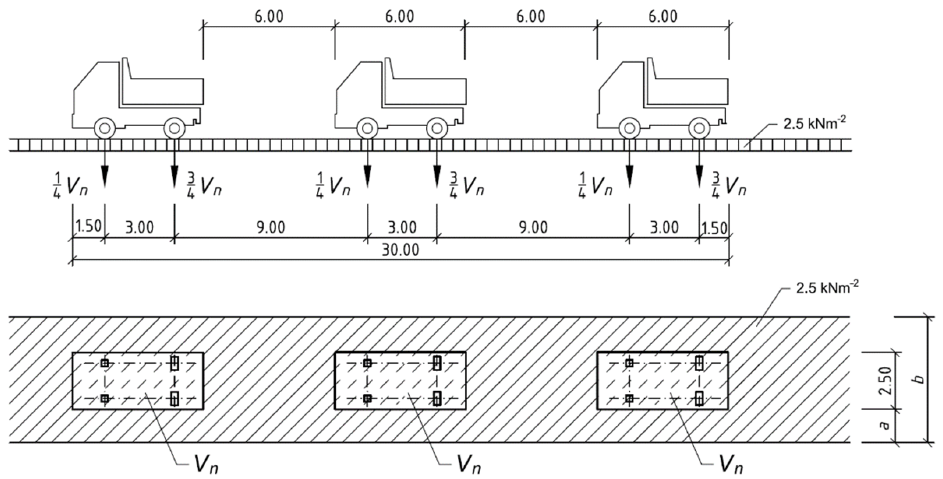
Figure 11. Load scheme used for normal load ‐ carrying capacity.